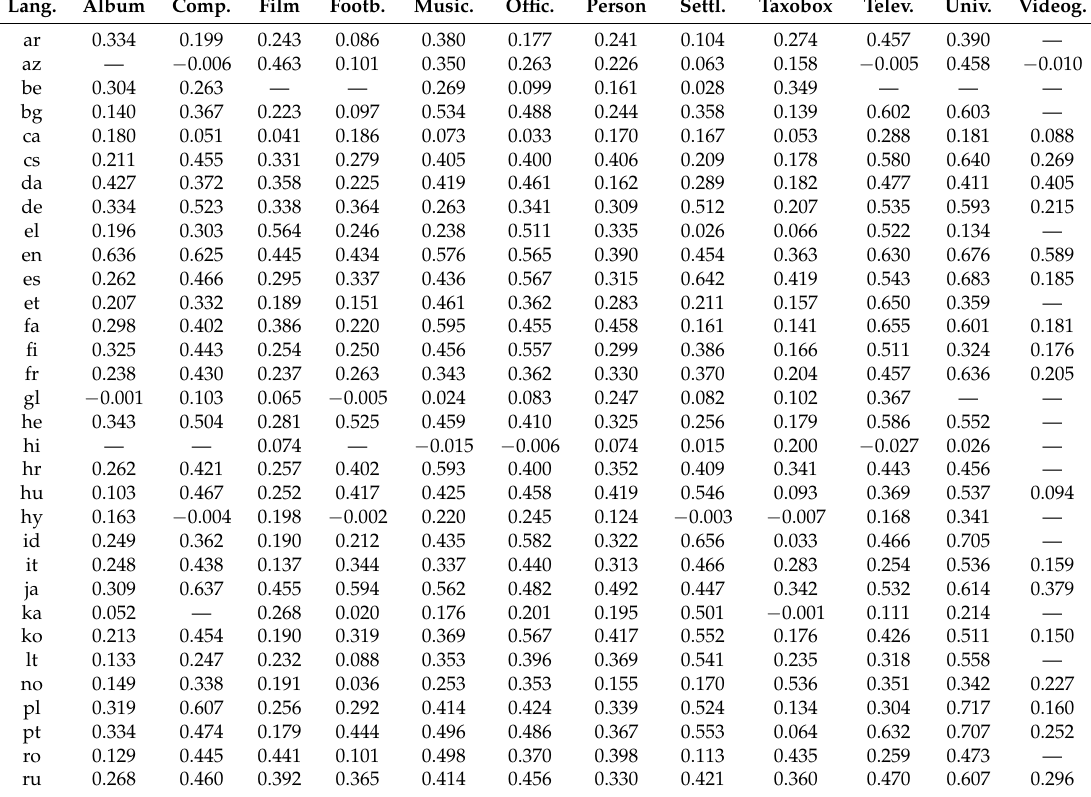
Table A3. Phi correlation coefficients of articles with the highest quality and popularity in selected Wikipedia languages. Source: own calculations.